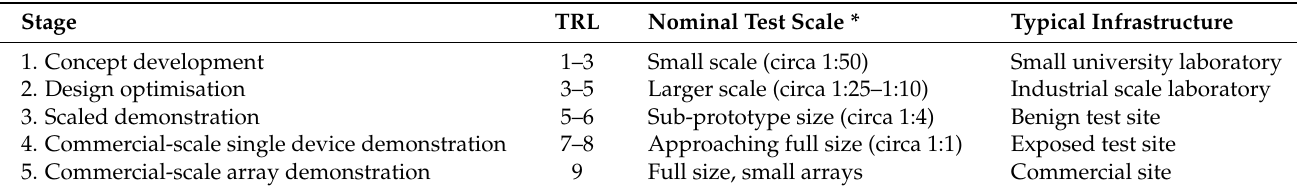
Table 1. Five stages of development, for marine renewable energy devices. After [2,5–8]. Stage TRL Nominal Test Scale